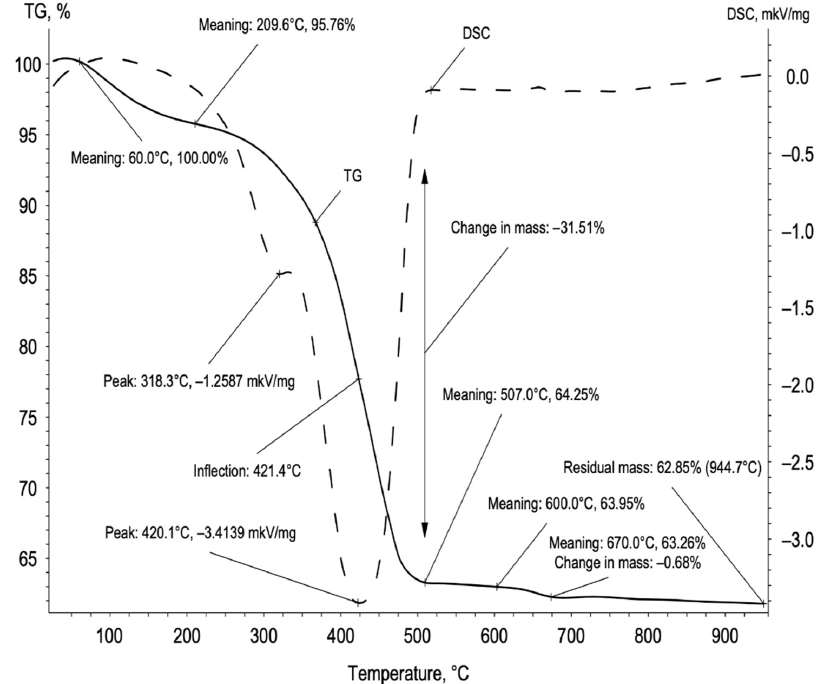
Figure 7. Results of thermogravimetric analysis of a sample of rice straw biochar modified by the electromagnetic method: TG—thermogravimetry, obtained by determining the mass loss during heating to high temperatures; DSC—differential scanning